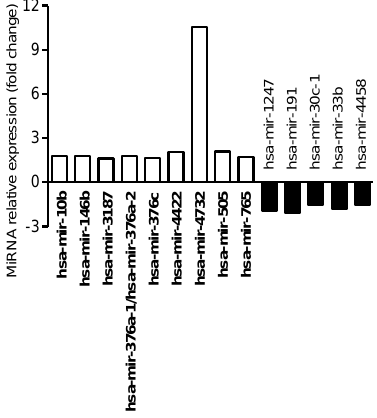
Figure 3. Dysregulated miRNAs in AIEC LF82-infected versus uninfected Caco-2-cl1 cells. A total of 10 7 LF82 bacteria were added into the apical compartment of Caco-2-cl1 monolayers. At 4 h post-infection, the monolayers were collected, washed with cold PBS, and total RNA was extracted and used for miRNA array analysis. The graph shows the relative expression of the miRNAs that were dysregulated in AIEC LF82-infected versus uninfected Caco-2-cl1 cells, presented as fold change (normalized to expression levels of miRNAs in uninfected Caco-2-cl1 cells, defined as 1).